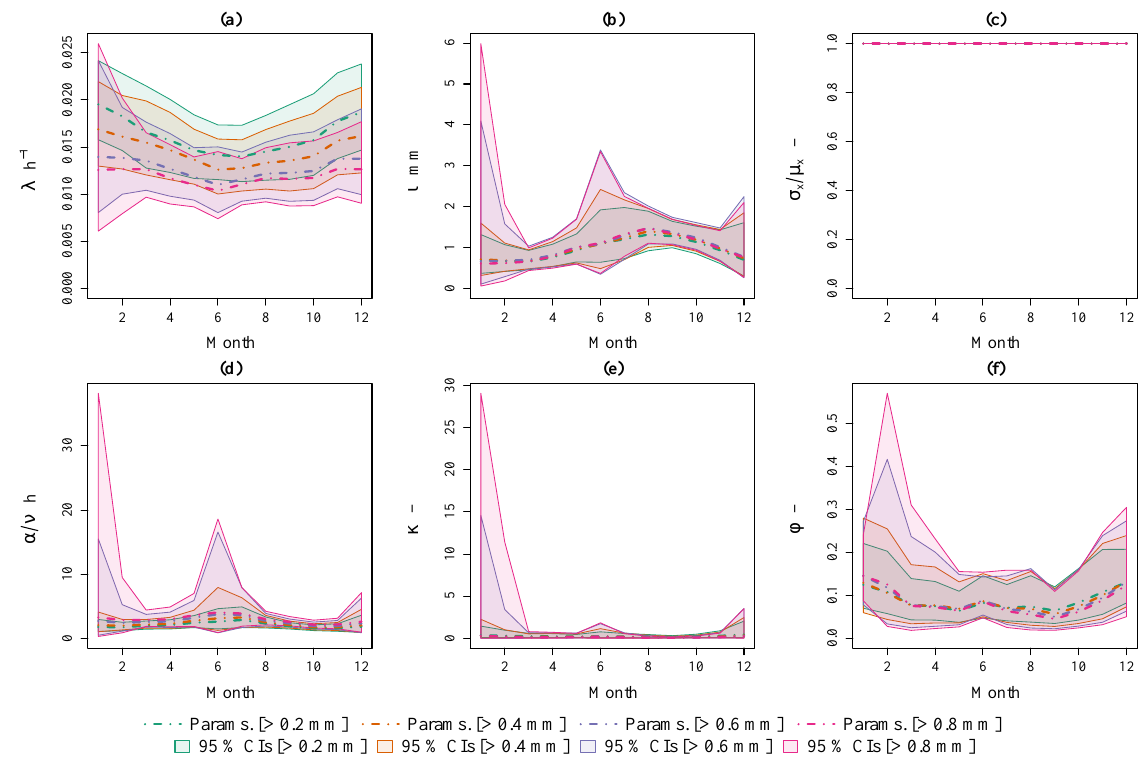
Figure 7. Comparison of censored BL1M model parameters for Atherstone 60min data. Optimal parameter estimates (params.) are shown with dot-dashed lines, and parameter uncertainty is represented with 95% confidence intervals